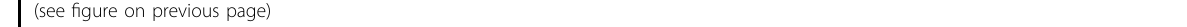
Fig. 2 miR-24-3p and miR-25-3p modulate Per2 gene expression at the posttranscriptional level. Wild-type mouse embryonic fi broblasts (WT MEFs) were transfected with miR-24-3p or miR-25-3p mimics in a dose-dependent manner (25, 50, and 100 nM) and then assayed for the expression levels of a miR-24-3p and miR-25-3p using real-time qPCR ( n = 4) and b quanti fi ed PER2 protein expression by Western blotting ( n = 3). To determine the effects of miR-24-3p and miR-25-3p on Per2 transcription, Period2::Luc knock-in mouse embryonic fi broblasts (Per2::Luc KI MEFs) were transfected with 0.5 µg of miR-24-3p- and miR-25-3p-overexpressing and control vectors, and then, actinomycin D (a potent transcription inhibitor) was added for 30 h after dexamethasone synchronization. c The results of real-time bioluminescence recordings are represented in raw data format after actinomycin D (solid line) and DMSO (dashed line) treatment. d Per2 mRNA was quanti fi ed after an additional 0 and 6 h of actinomycin D treatment (Per2::Luc KI MEFS were harvested as indicated by the arrowheads), and the data were normalized to that of the control vector ( n = 4). Data are presented as the means ± SE, and the signi fi cance was assessed by one-way ANOVA, * p < 0.05 compared to the control